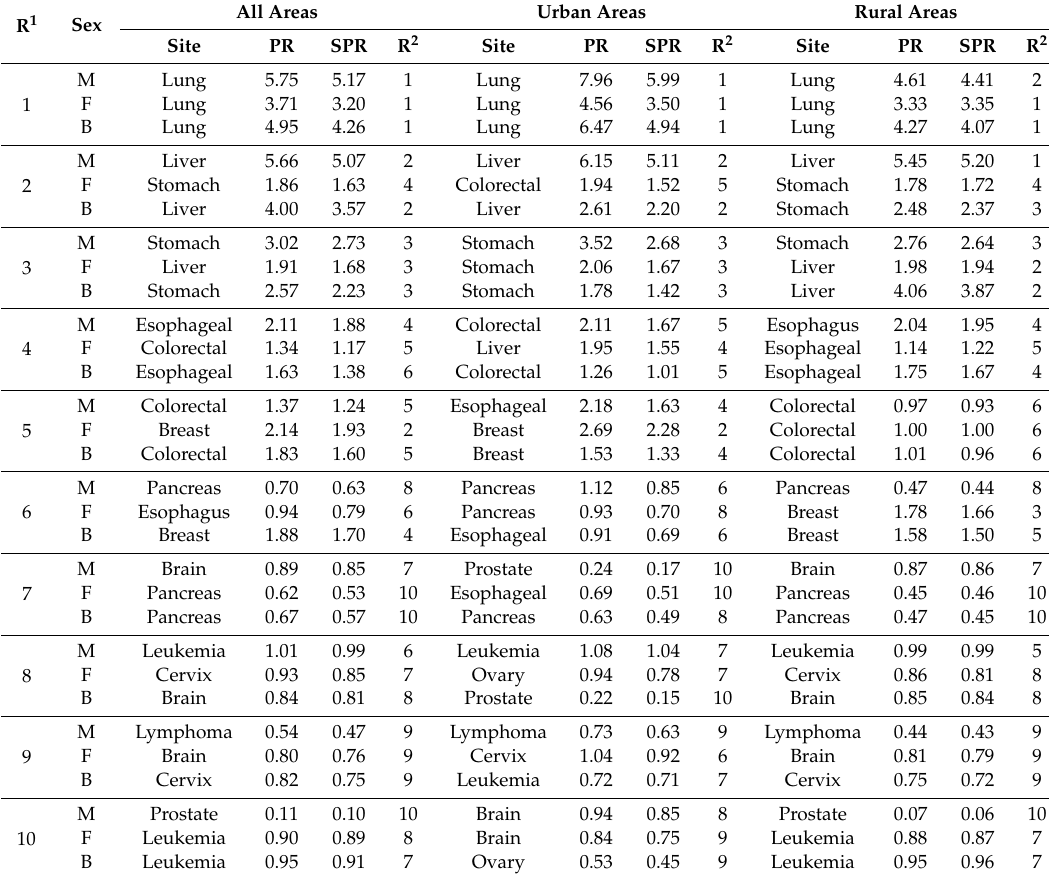
Table 2. Potential years of life lost (PYLL) and ranks of the high death-risk cancers in China, 2013( / 10 3 ). All Areas Urban Areas Rural R 1 Sex